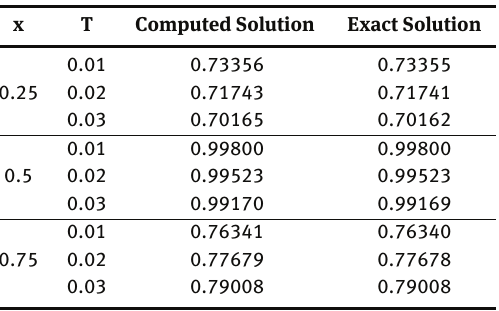
Table 6: Comparison of exact solution and the computed numerical solution at different times for Example-2 at ν = 0.02 , Δx = 0.0125 and Δt = 0.001